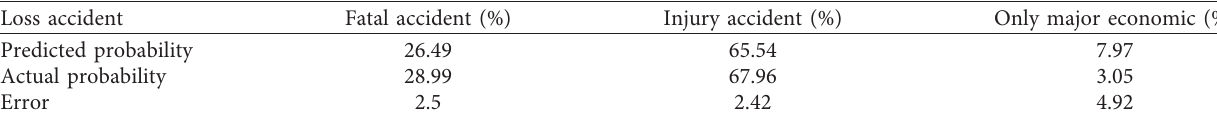
Table 5: Accuracy of predicting severity of urban bus operation accidents.